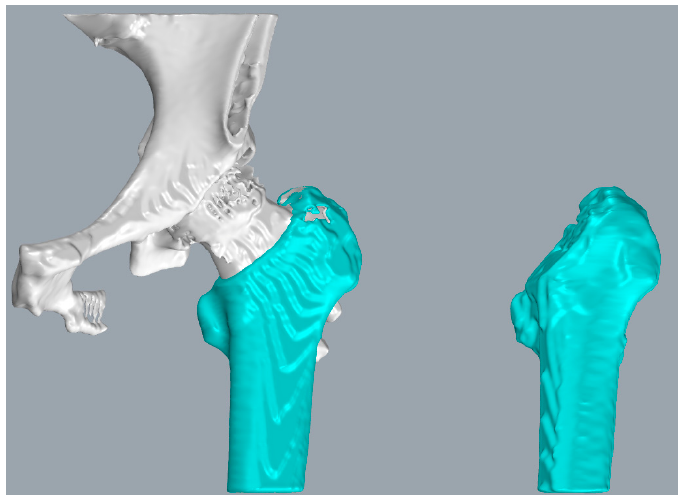
Figure 4. Selected partial femur model containing the greater trochanter and intertrochanteric crest, with the interior filled to use it as a